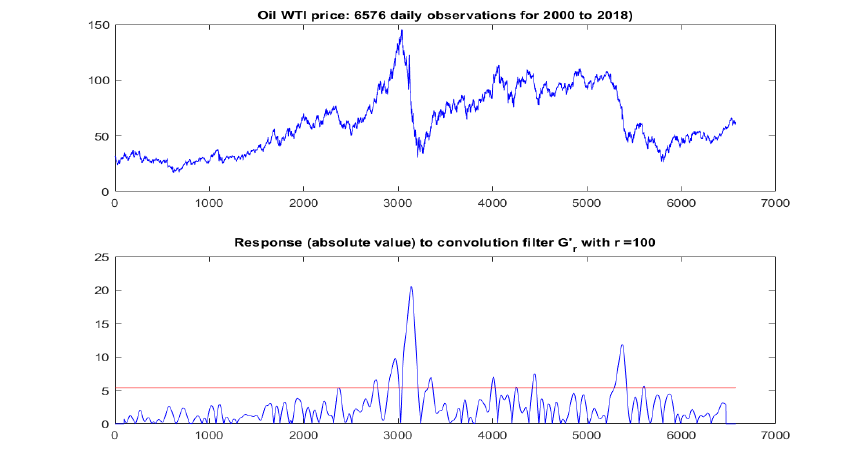
Figure 2. Top: Oil price data: 6576 daily observations for the period 2000–2018; Bottom: Response R ( t ; r = 100 ) (defined in Equation (4)) after convolution with the smoothed first derivative ( G (cid:48) r ). As expected, there was a clear peak corresponding to sharp downturn around observation 3000. The size of this peak was measured relative to the 90&-percentile of the response (indicated by the red line), yielding an observed value of T obs = 3.82 (see also Equation